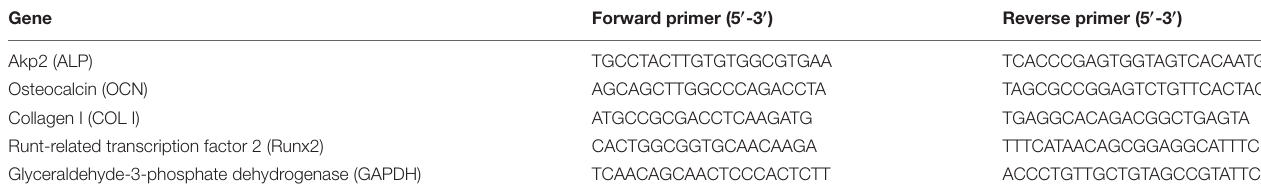
TABLE 1 | Primers sequences for rt-PCR. Gene Forward primer (5 (cid:48) -3 (cid:48) ) Reverse primer (5 (cid:48) -3 (cid:48) ) Akp2